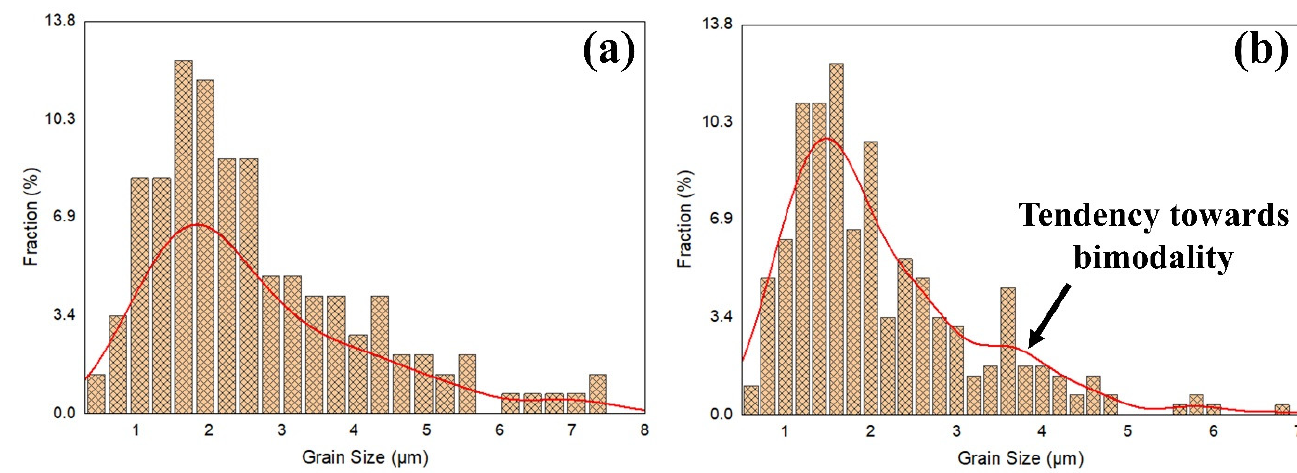
Figure 4. Grain size distribution for scanning electron micrographs corresponding to ( a ) Figure 3a ( b ) Figure 3b.